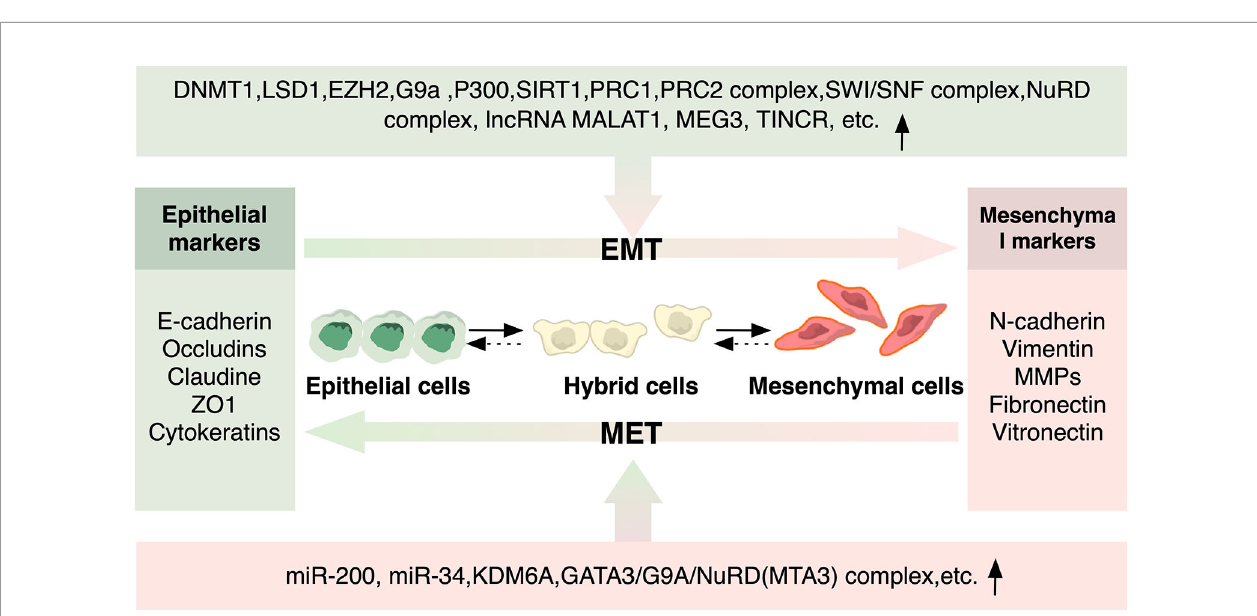
FIGURE 3 | Epigenetic Regulators of EMT and MET. Epigenetic modulators involved in histone modi fi cation, DNA methylation, and non-coding RNA in EMT/MET that regulate cancer metastasis are depicted. Epigenetic regulators can either be recruited by EMT-TFs to regulate the expression of downstream EMT-associated genes, or they can directly function as either transcriptional suppressor or activators of EMT-TFs as well as downstream EMT-associated